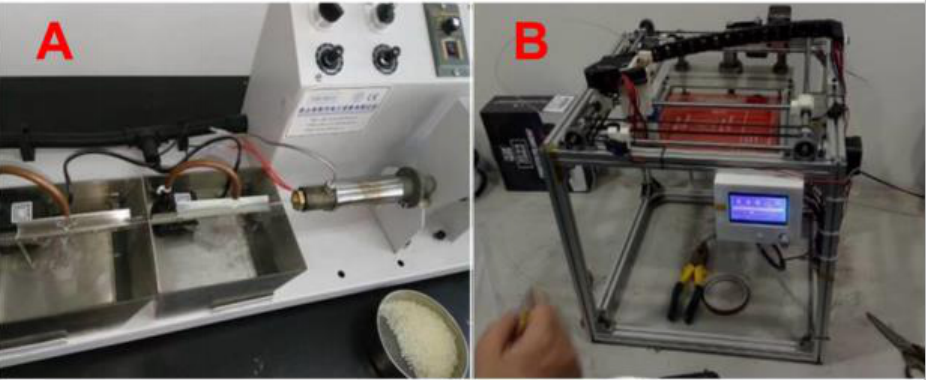
Figure 1. ( A ) Drawing machine; ( B ) FDM 3D printer.